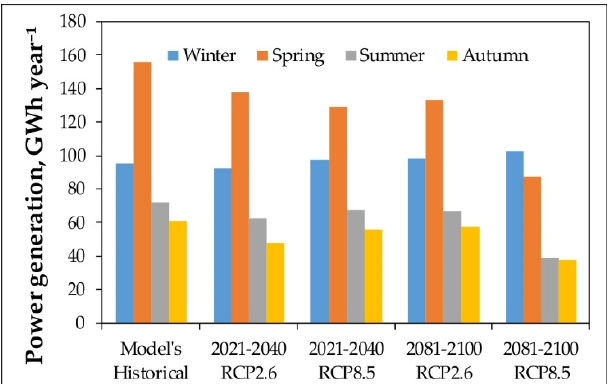
Figure 9. Projection of the seasonal energy production in Kaunas HPP in the near and far future and its change compared to 1986–2005.